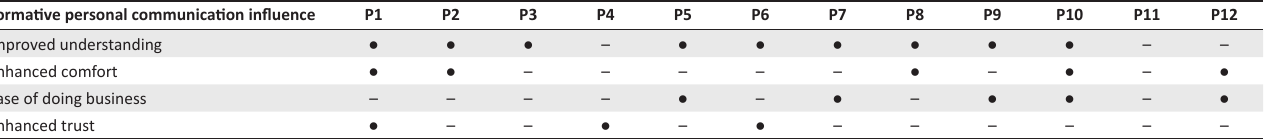
TABLE 7: Formative personal communication influence. Formative personal communication